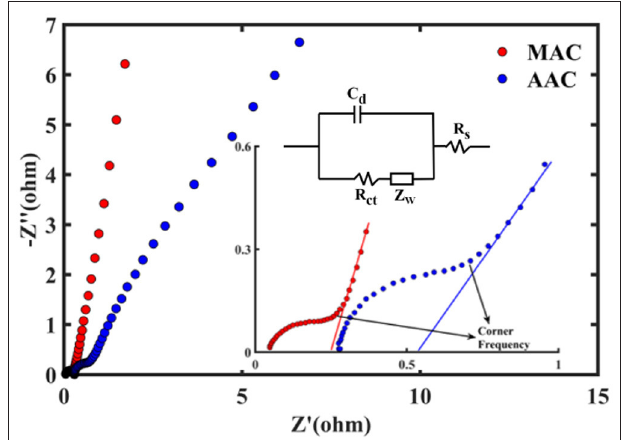
FIGURE 7 | Nyquist plots of the MAC and AAC electrodes in a frequency ranged from 0.01 to 100kHz and the inset of the high frequency region and corner frequency and the equivalent circuit.